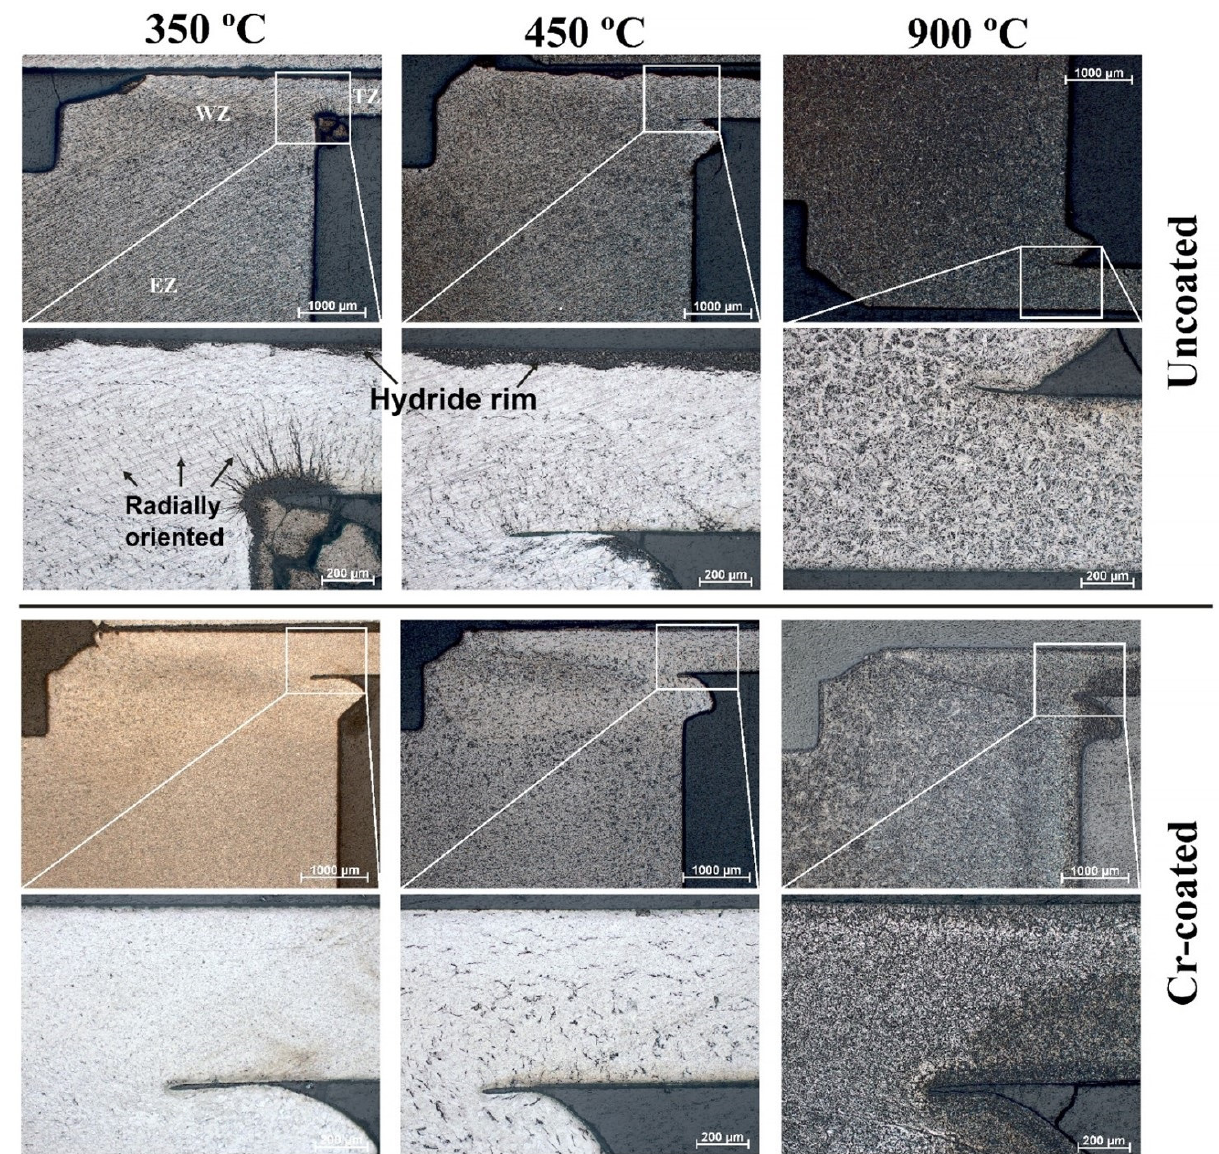
Figure 4. Optical images of cross-section microstructure of Cr-coated and uncoated RUW specimens after hydrogenation tests at 360, 450, and 900 °C.